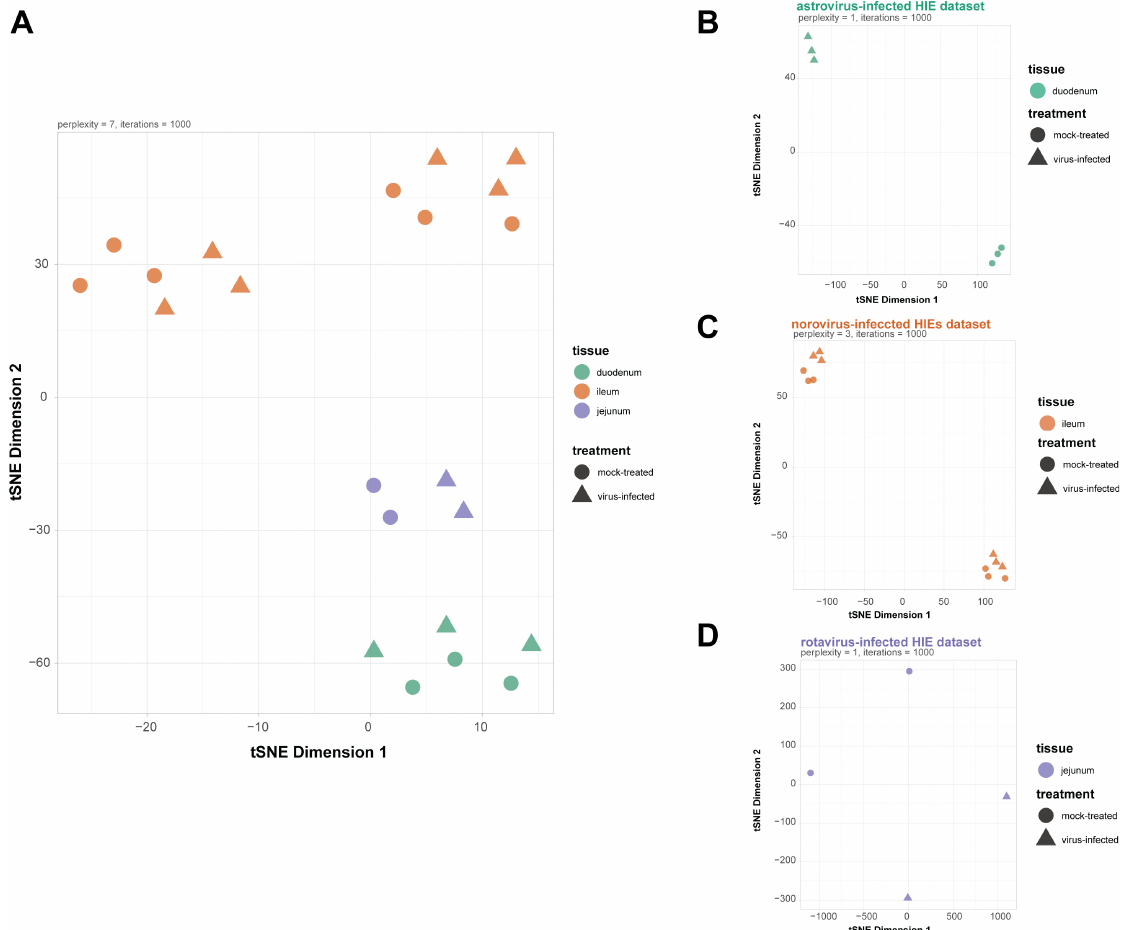
Figure 1. Samples across the three datasets showed divergence due to tissue origin of the HIE line but due to viral infection when looking at each dataset individually. Nonlinear dimensionality reduction with t-SNE of the 16 samples belonging to the three datasets were analyzed. Samples are colored by the segment of the small intestine that was used to derive HIE and each one of the datasets corresponds to a different small intestinal segment (duodenum, ileum and jejunum). The t-SNE plot shows that clustering is primarily driven by the tissue origin of HIE ( A ). Nonlinear dimensionality reduction with t-SNE for each individual dataset (6, 12 and 4 samples for astrovirus-infected ( B ), norovirus-infected ( C ), and rotavirus-infected ( D ) HIEs datasets, respectively) shows clustering of samples due to treatment (mock-treated versus virus-infected) as well as the HIE line since in the norovirus-infected and rotavirus-infected HIE datasets more than one HIE line were used. Plots were generated with Rtsne and perplexity values were chosen for each plot after stability.